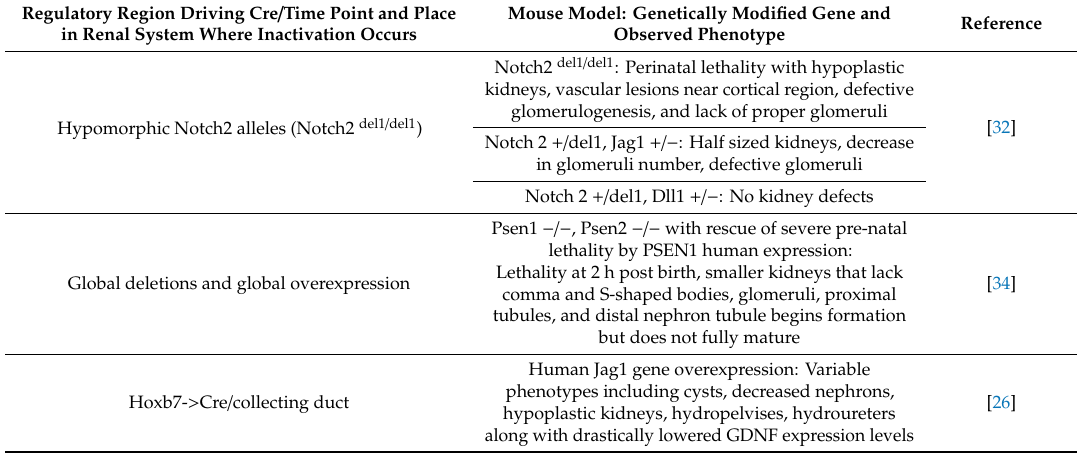
Table 1. Phenotypes of mouse models with Notch signaling activity modulated within the developing kidney. Regulatory Region Driving Cre / Time Point and Place in Renal System Where Inactivation Occurs